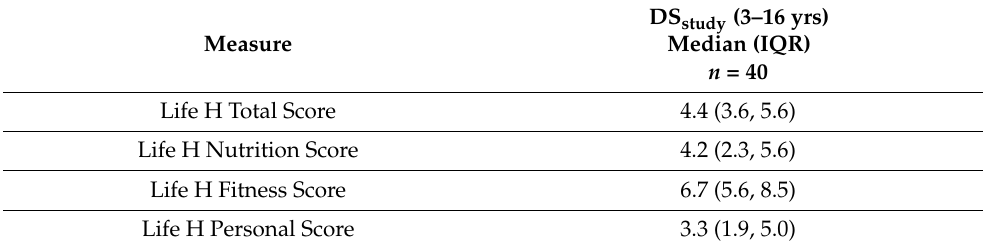
Table 3. Life Habits (Life-H) Questionnaire data for participants ( n =